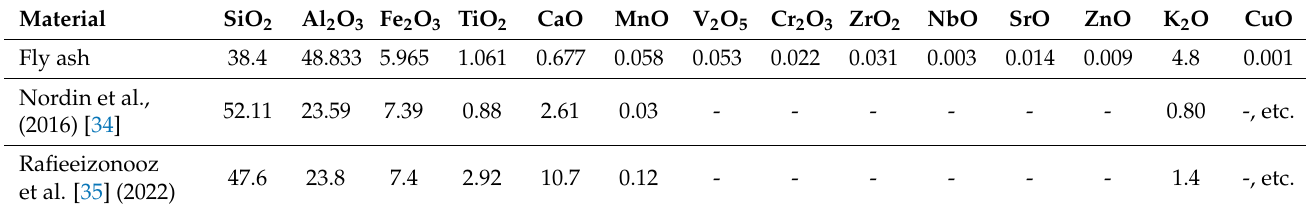
Table 3. Chemical composition of fly ash.